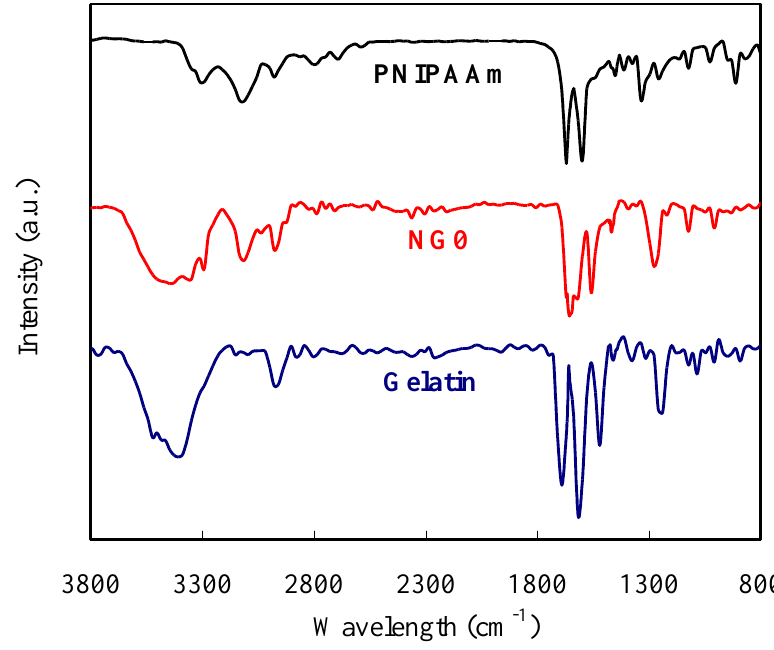
Figure 1. Fourier transform infrared spectroscopy (FTIR) spectra of gelatin, NG0, and poly( N -isopropylacrylamide) (PNIPAAm).